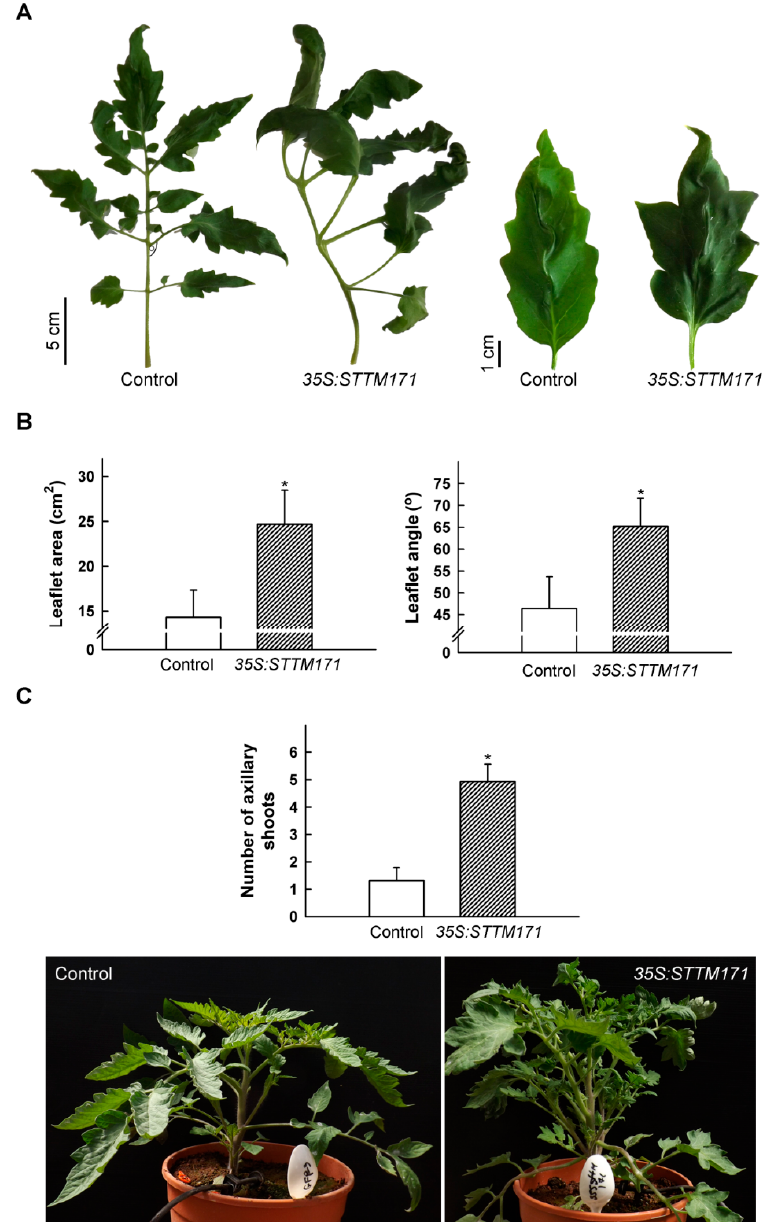
Figure 3. Vegetative phenotypes of 35S:STTM171 plants. ( A ) Photograph of representative fifth leaf and terminal leaflet from 45 DAG plants of indicated genotypes. ( B ) Quantitation of primary leaflet area and petiolule angle (indicated in (A)) in leaves (n = 26) similar to those shown in (A). ( C ) Quantitation of the number of axillary shoots on the main stem ( ≥ 0.5 cm) at eight leaf stage plants (n = 13). Error bars indicate ± SD. Asterisks indicate significant difference as determined by Student’s t -test ( p ≤ 0.001). Representative plant of each genotype is shown below. Pot diameter = 18.8 cm.